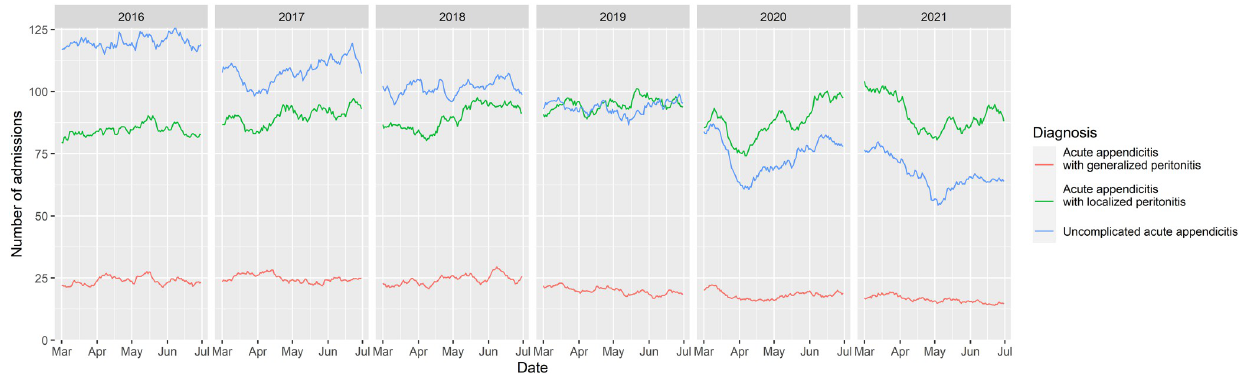
Fig 1. The overall trend of acute appendicitis from 2016 to 2021.